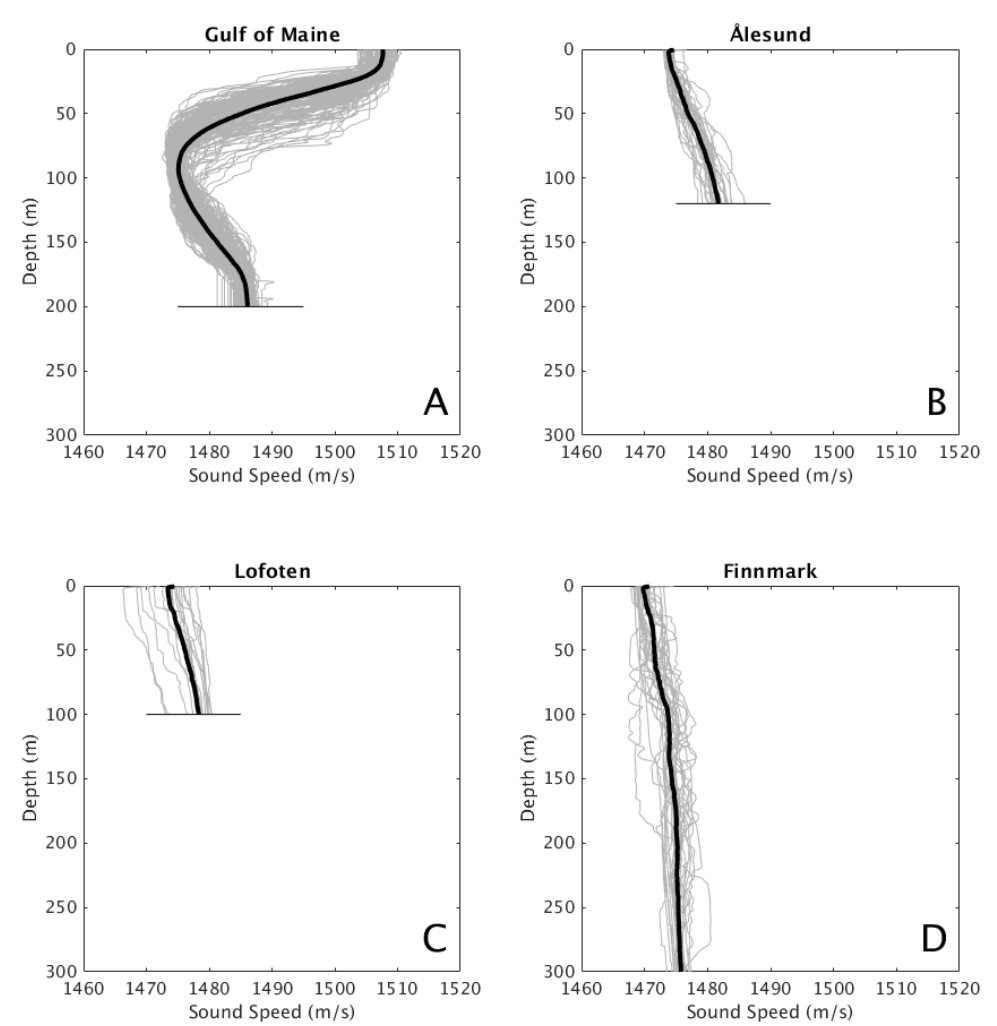
Figure A2. Profiles of water-column sound speed from XBT measurements in the Gulf of Maine ( A ), Ålesund waters ( B ), Lofoten waters ( C ) and Finnmark waters ( D